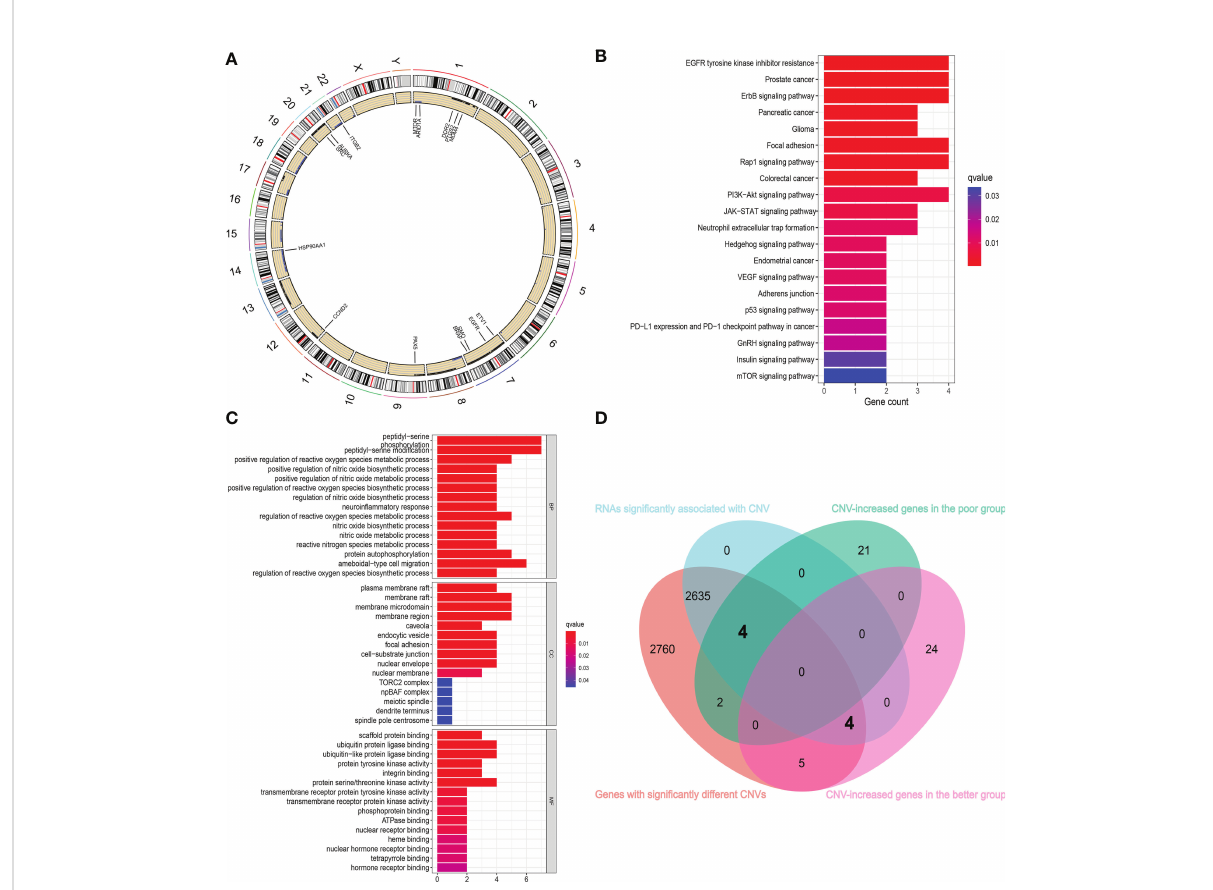
FIGURE 5 Combining with TCGA cohort to further identify the genes associated with chemosensitivity. (A) The chromosomal locations of 15 overlapped genes and CNV alterations. (B, C) The KEGG (B) and GO (C) enrichment analysis of 15 overlapped genes showed that they are signi fi cantly enriched in many energy metabolism pathways and classic cancer-related signaling pathways. (D) The Venn diagram showed the gene sets screened from different